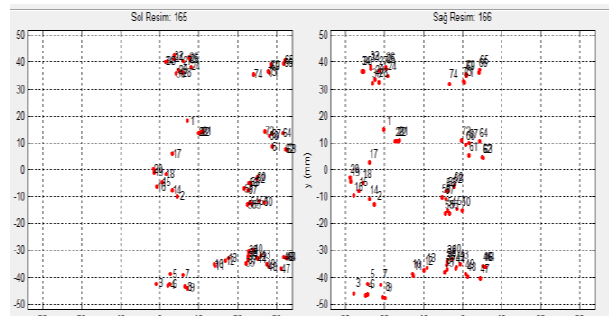
Figure1. Distribution of tie points in both images Horizontal position uncertainty is determined as σ xy = 0,97 m and vertical position uncertainty is determined as σ z = 2,49 m at the end of implementation with the parameters shown above. Position uncertainty of X, Y and Z components for each point and position uncertainty distribution as colorized surface for whole stereo model generated by interpolation from those points is shown through Figure 2 – Figure